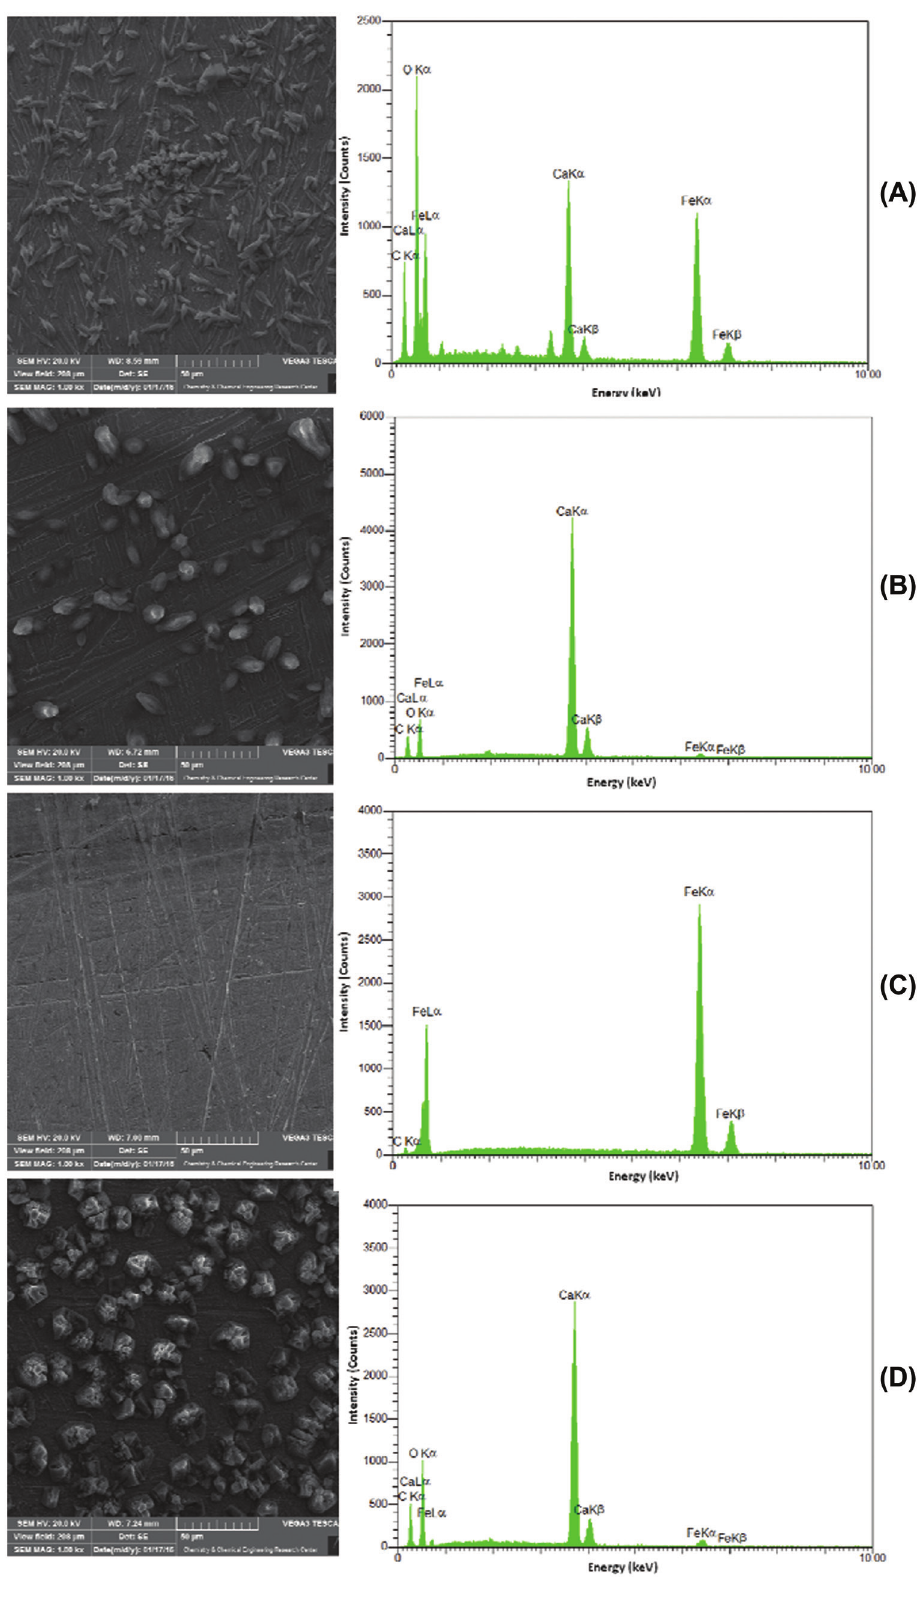
Figure 8: Scanning electron microscopy (SEM) and energy dispersive X-rays spectroscopy (EDX) images of steel electrode after 3 h chronoamperometry in (a) the absence, and the presence of (b) 5%, (c) 10 and (d) 20% Gypsophila aretioides